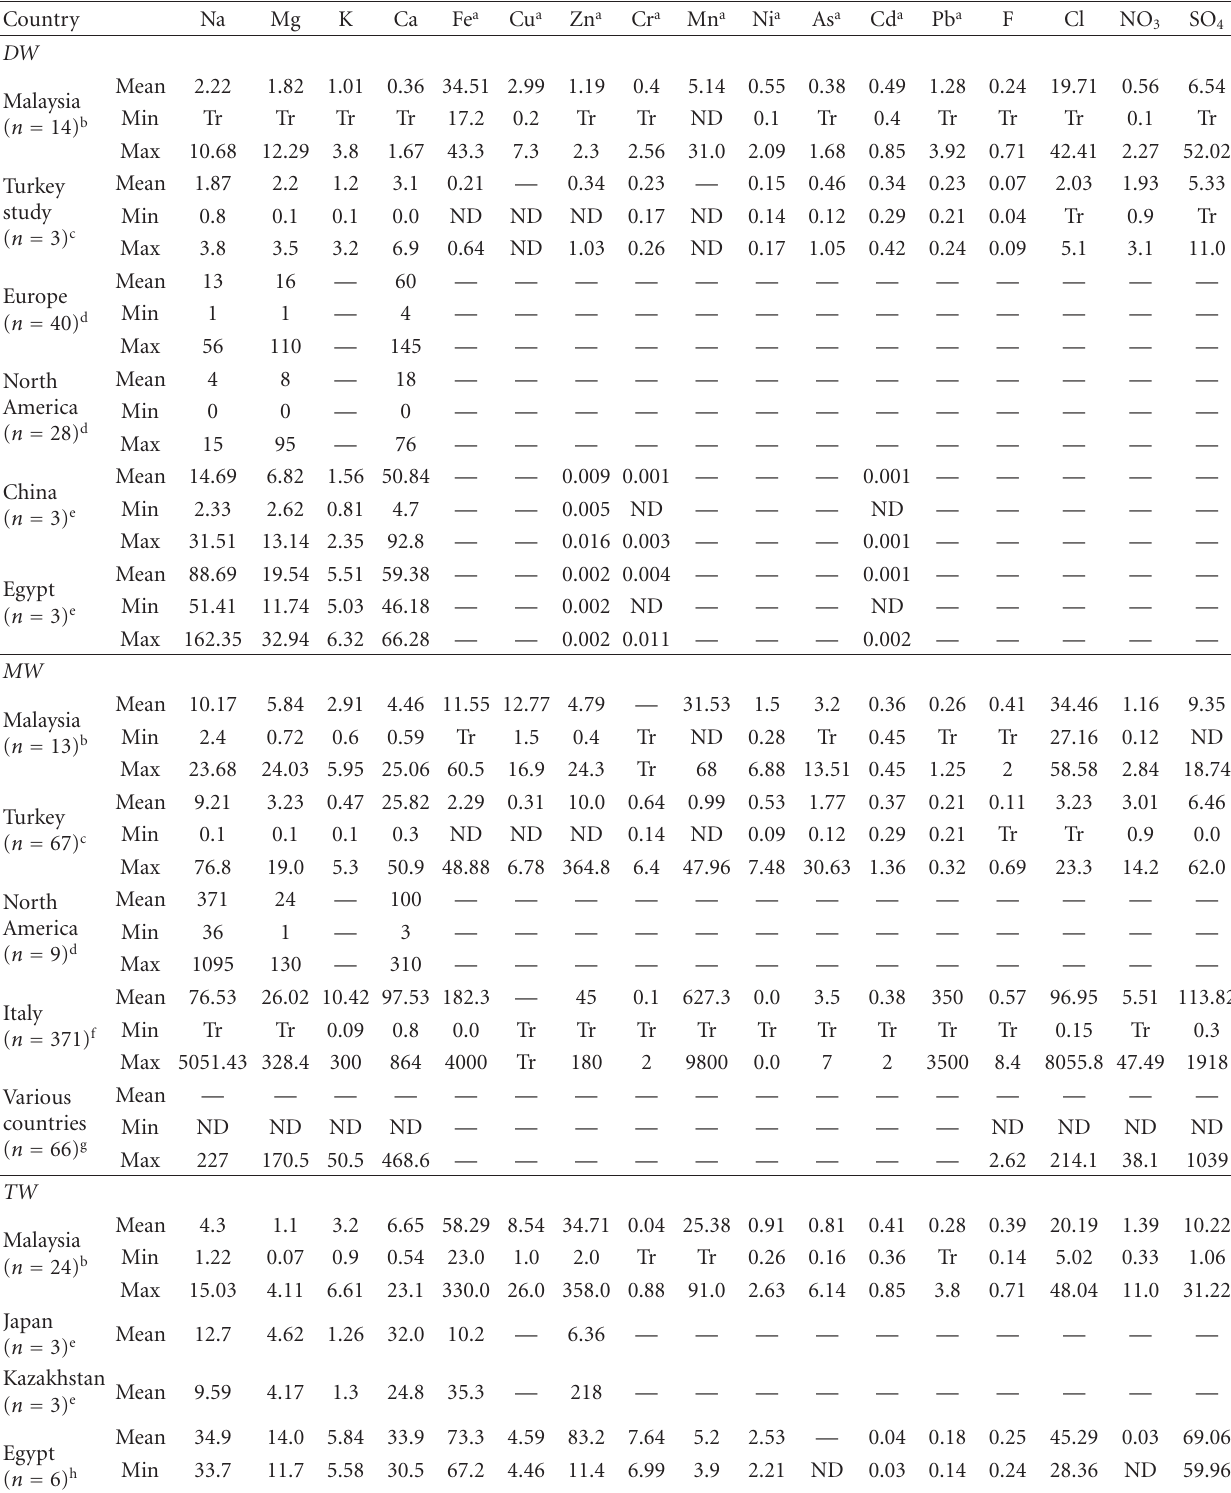
Table 6: Mineral contents in packaged drinking water (DW), mineral water (MW), and tap water (TW) samples from Malaysia and other